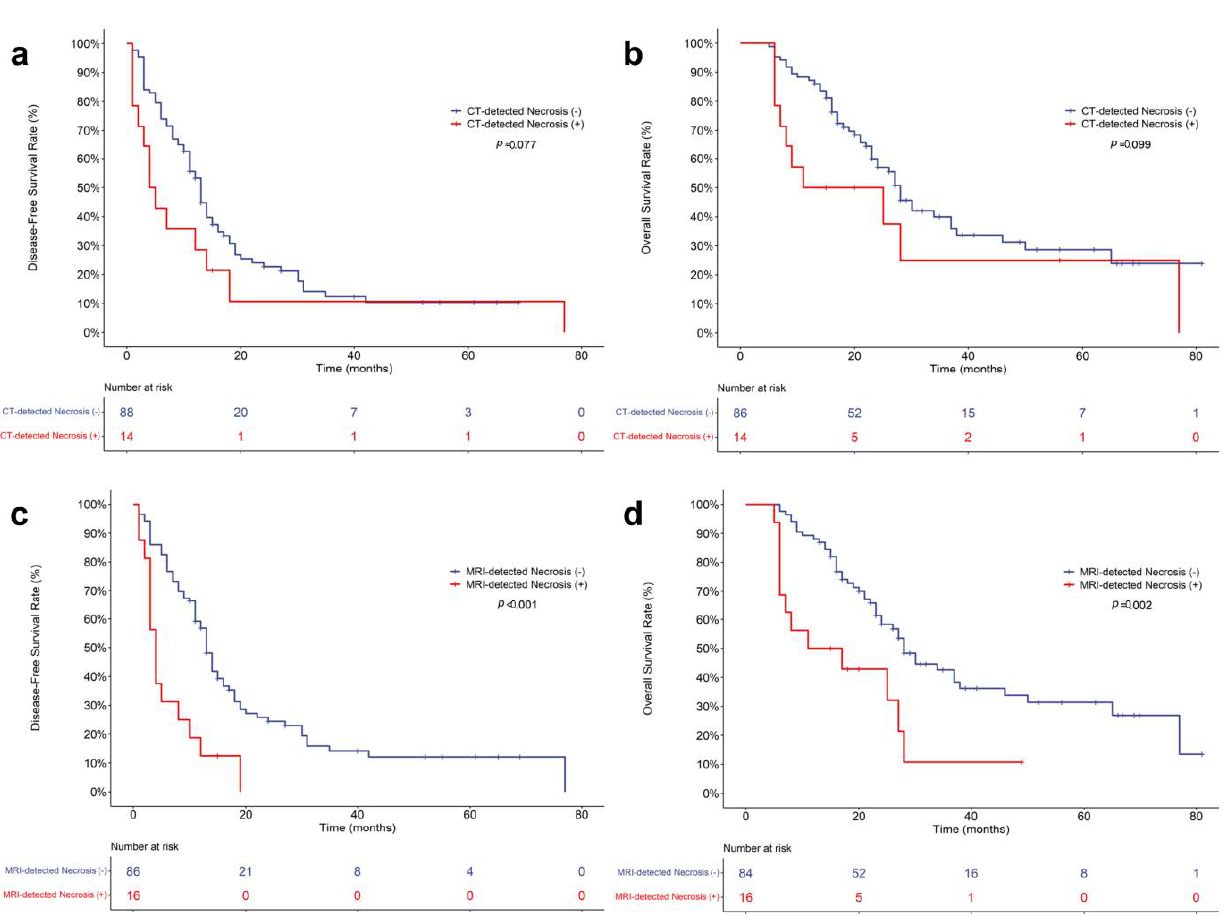
Figure 3. Kaplan–Meier curves for postoperative survival outcomes of pancreatic ductal adeno- carcinoma patients. Comparison of disease-free survival ( a ) and overall survival ( b ) according to the presence of CT-detected necrosis. Comparison of disease-free survival ( c ) and overall survival ( d ) according to the presence of MRI-detected necrosis.